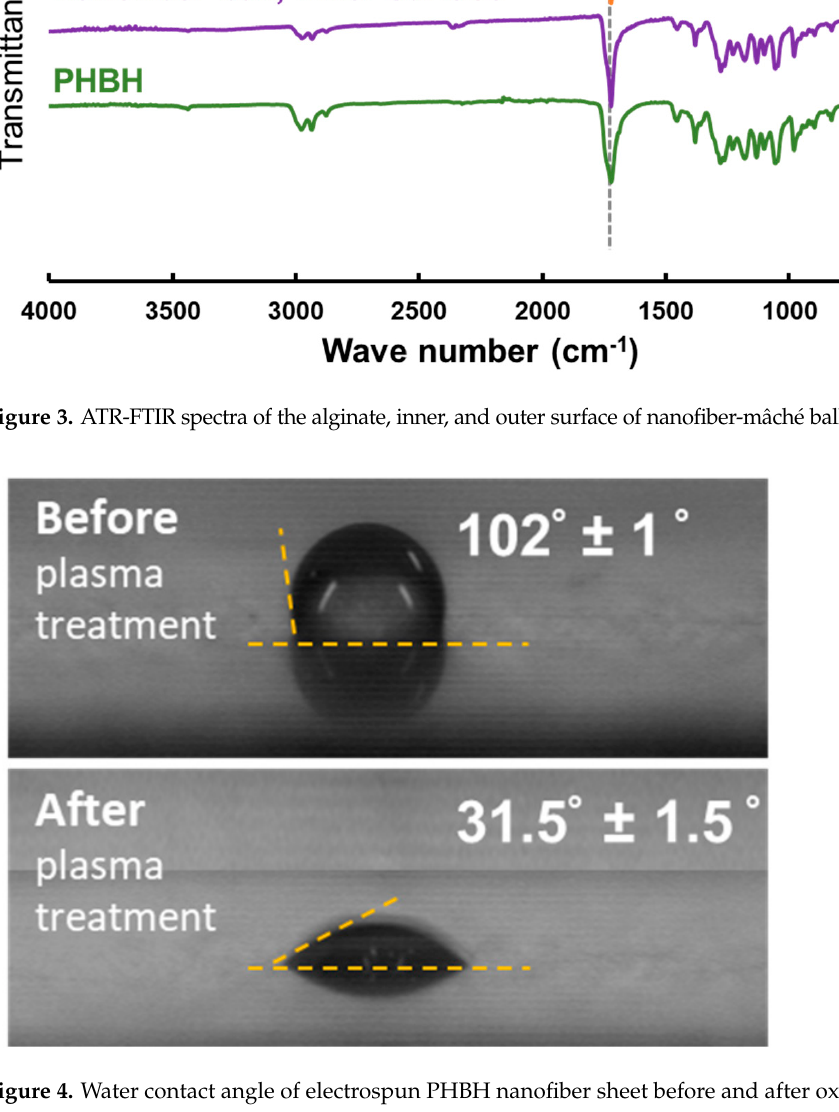
Figure 4. Water contact angle of electrospun PHBH nanofiber sheet before and after oxygen plasma